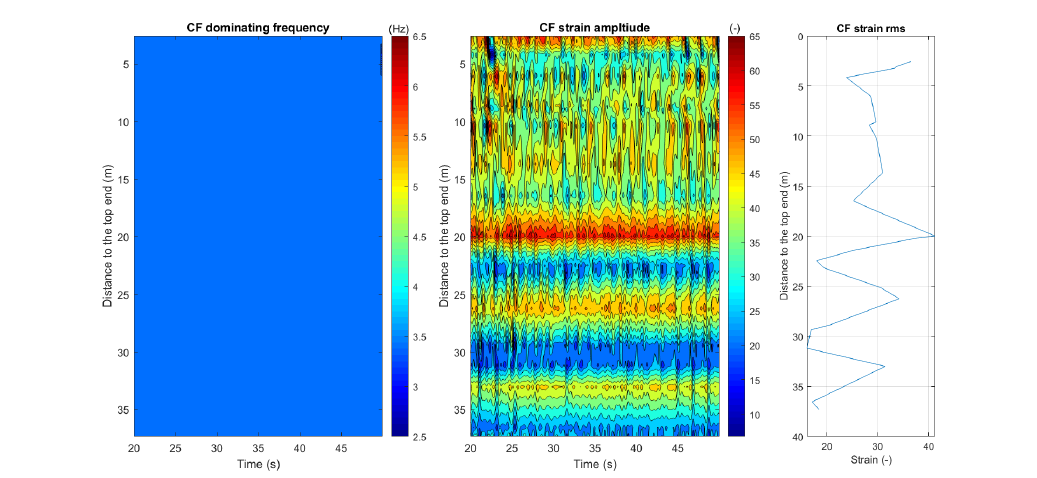
Figure 1. Single-frequency response, low mode ( ∼ 5), tension dominating, NDP high-mode test case 2350 [13].